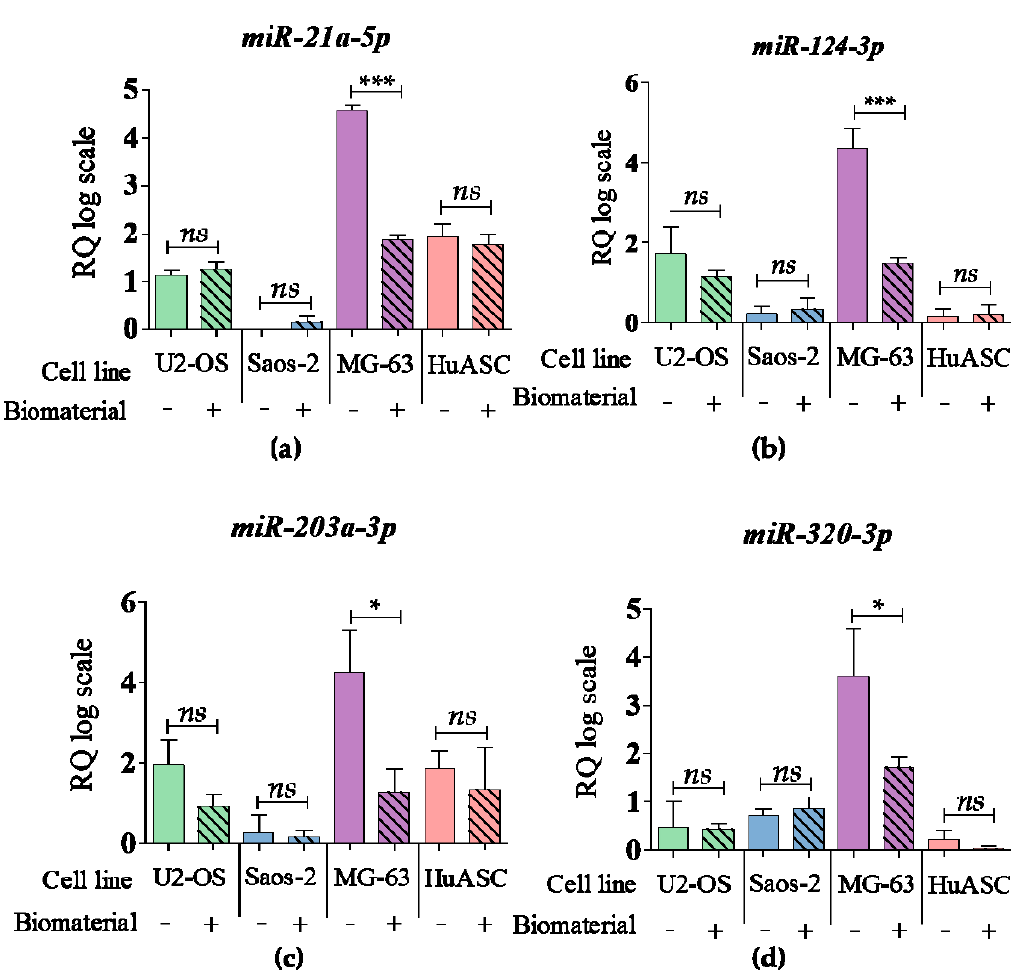
Figure 7. The analysis of miRNA level. The examined targets were: ( a ) miR-21a-5p, ( b ) miR-124-3p, ( c ) miR-203a-3p, ( d ) miR-320-3p. An asterisk marks a statistically significant di ff erences determined between tested culture circumstances (* p < 0.05, ** p < 0.01, *** p < 0.001). The expression of miRNA were measured using the RT-qPCR technique, the relative quantification (RQ) was performed using 2 -DDCt method and scaling to the sample with highest expression of target gene. The results are expressed as mean ± SD.